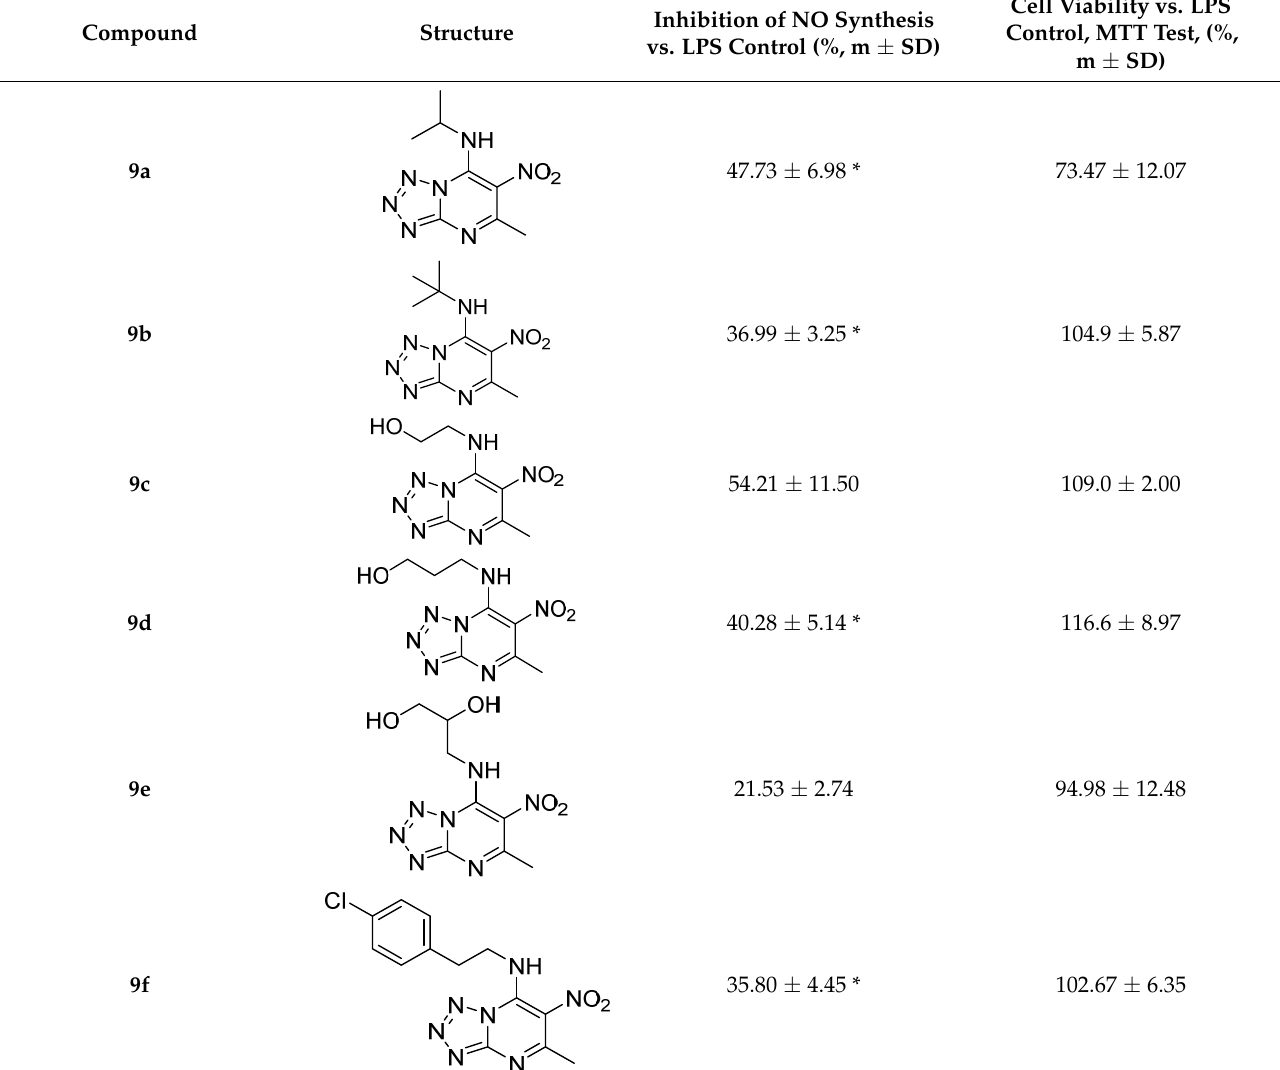
Table 1. Effect of heterocycles obtained at a concentration of 100 µM on LPS-stimulated macrophages of mice.